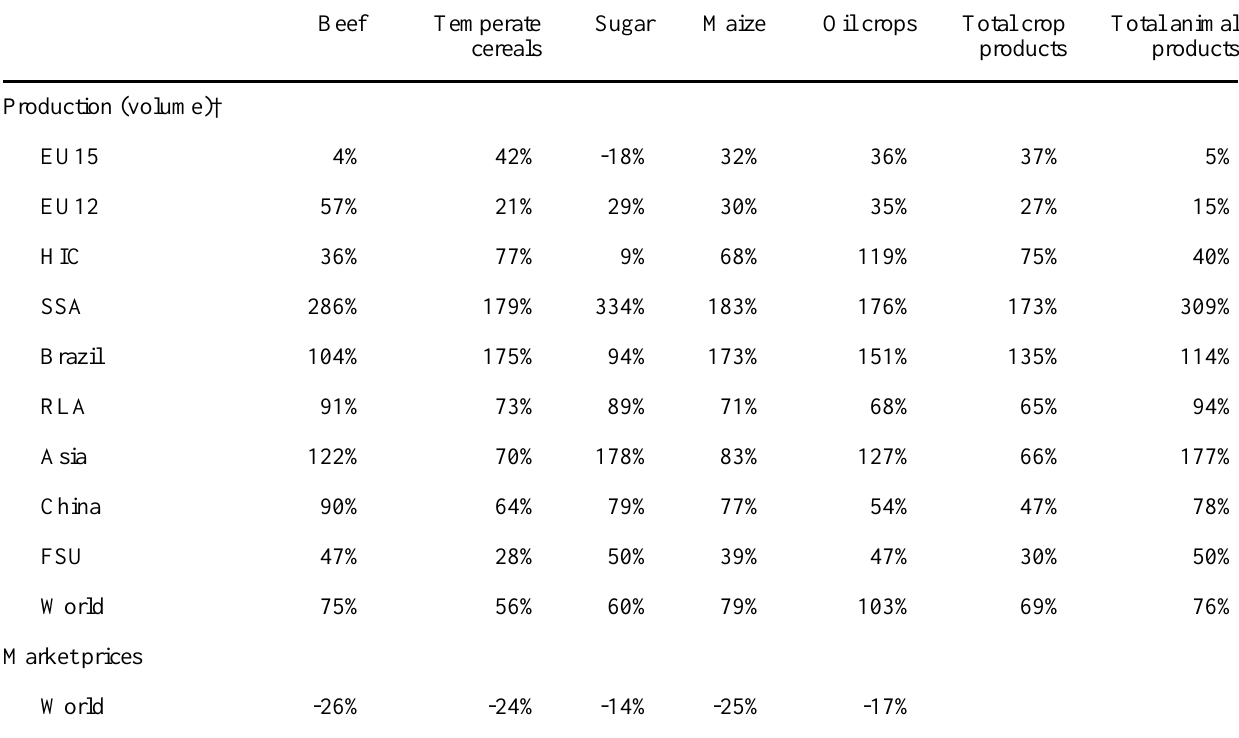
Table 3 . Changes in production and market prices in the Baseline of beef, temperate cereals, sugar, maize, and oil crops and for the aggregates “total crop products” and “total animal products” (2030 relative to 2000). Beef Temperate Sugar Maize Oil crops Total crop Total animal cereals products